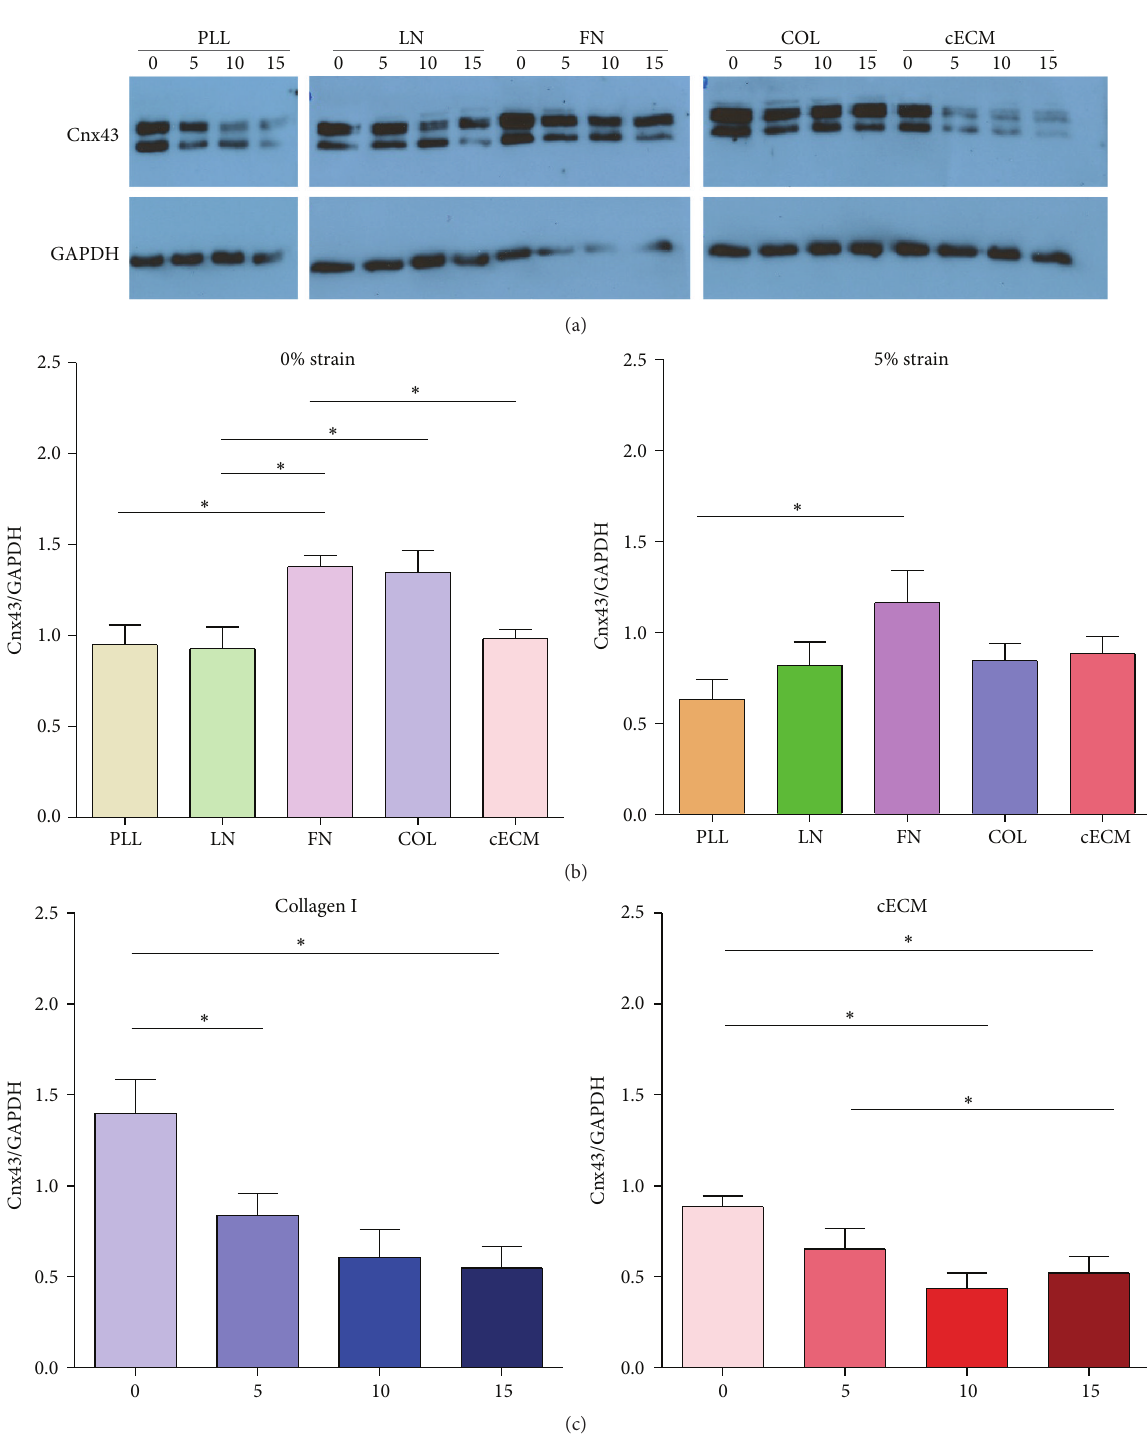
Figure 5: CPC connexin43 expression is highest at low strain magnitudes. CPCs were seeded on each matrix for 6 hours and then cyclic strain was applied for 24 hours. Connexin43 expression was assessed by western blot. (a) Representative blots and (b-c) densitometry quantification. One-way ANOVA with Tukey’s multiple comparison test; bars represent mean + SEM; ∗ 𝑝 < 0.05 ; 𝑛 = 4 –7. (b) Matrix-dependent effects. (c) Strainmagnitude-dependenteffects.PLL(brown):poly-L-lysine,LN(green):laminin,FN(purple):fibronectin,COL(blue):collagenI,cECM (red): naturally derived cardiac extracellular matrix, 0–15: strain magnitude (%), and Cnx43: